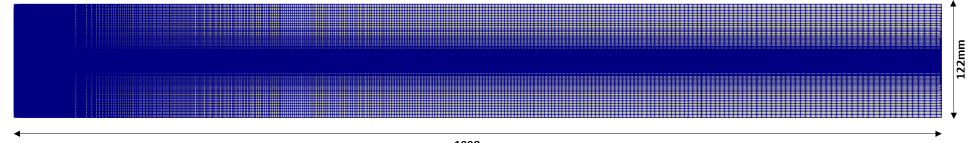
Figure 12. Section along the axis of mesh 2 showing mesh discretisation along the axis and near the